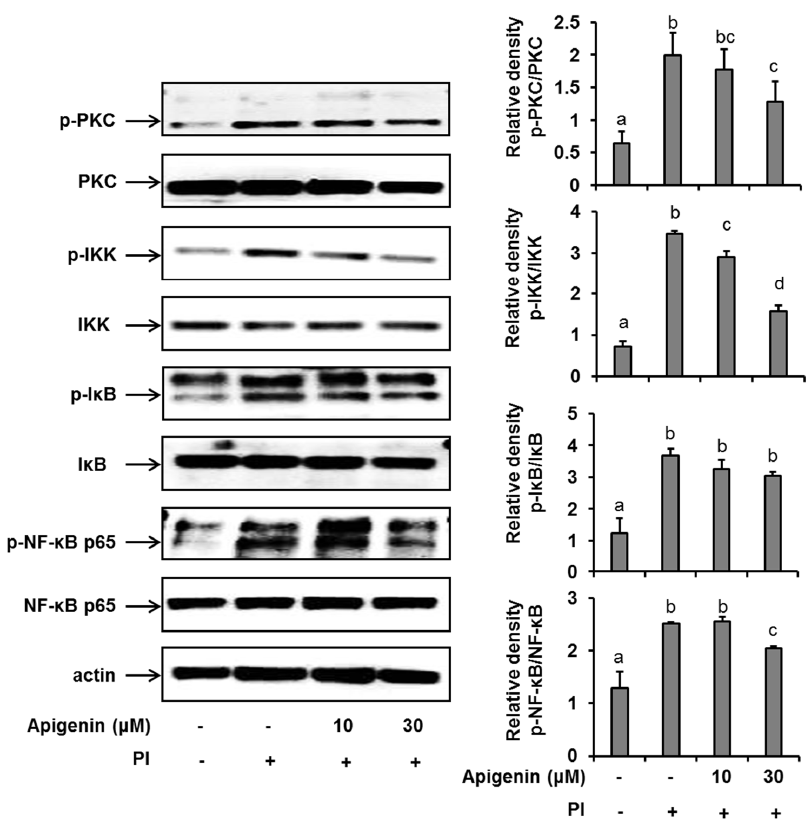
Figure 3. Effects of apigenin on the NF- κ B signaling pathway in HMC-1 cells. Cells were pre-treated with apigenin at indicated concentrations for 1 h prior to PI stimulation for 30 min. Western blot analysis was performed to evaluate the expressions of molecules of the NF- κ B signaling pathway in the cells. The bands were quantitated using Image J analysis software tool. The data presented are the means ± SD of three independent experiments. Bars with different small case letters indicated statistically significant difference at p < 0.05. PI, phorbol-12-myristate 13-acetate (50 nM) and ionomycin (1 µ M).